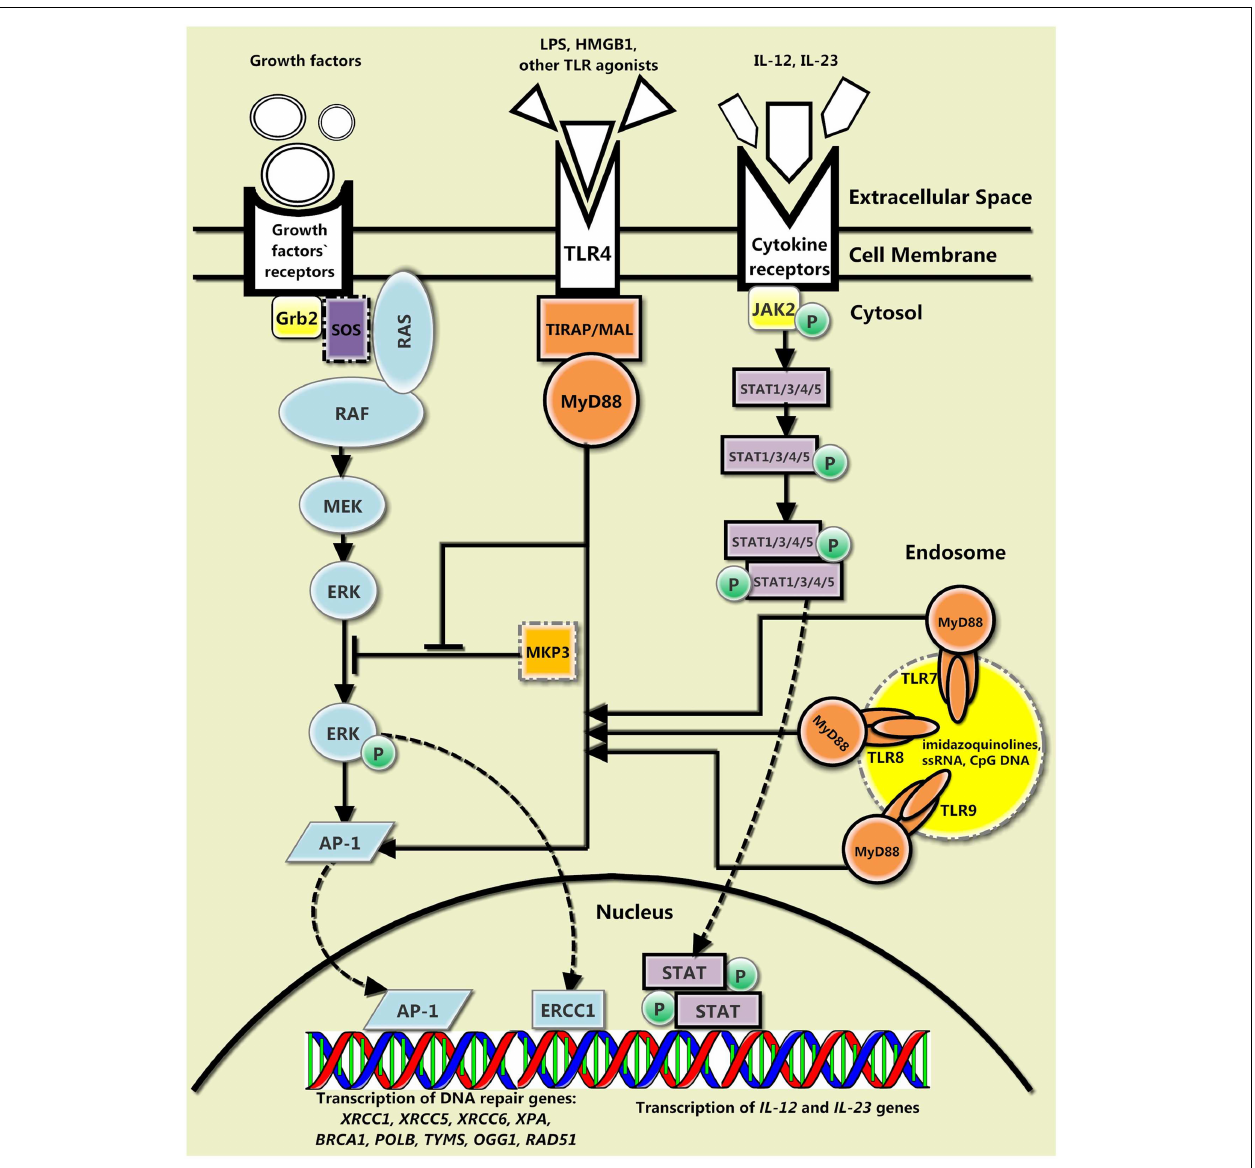
signaling via Ras-MAPK pathway. In addition, MyD88 and its downstream signaling proteins (not shown) along with pERK activate AP-1 transcription factor, which promotes transcription of certain DNA repair genes. Finally, IL-12 and IL-23, which enhance DNA repair and whose transcription is also amplified by MyD88-regulated transcription factors, bind to their receptors, activate Janus kinase-signal transducer and activator of transcription (JAK-STAT) signaling pathway, and increase further transcription of their own encoding